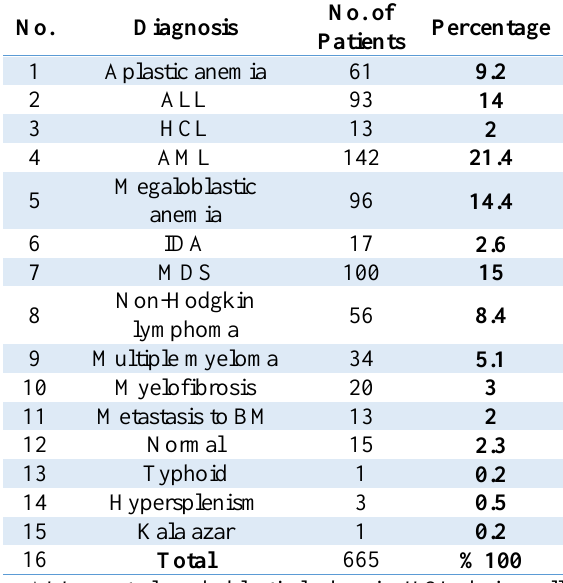
Table1. The Etiology of Pancytopenia Based on Biopsy Findings in Patients Diagnosis No.